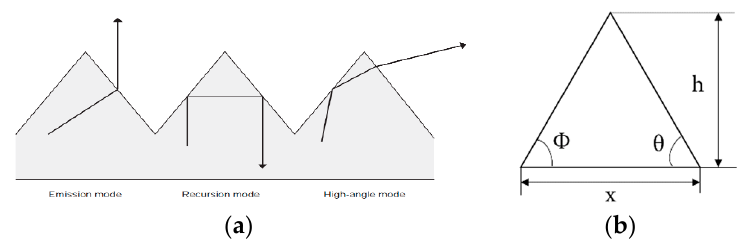
Figure 5. ( a ) behavior of light rays in the prisms layer; ( b ) the parameter of a unit of prism.